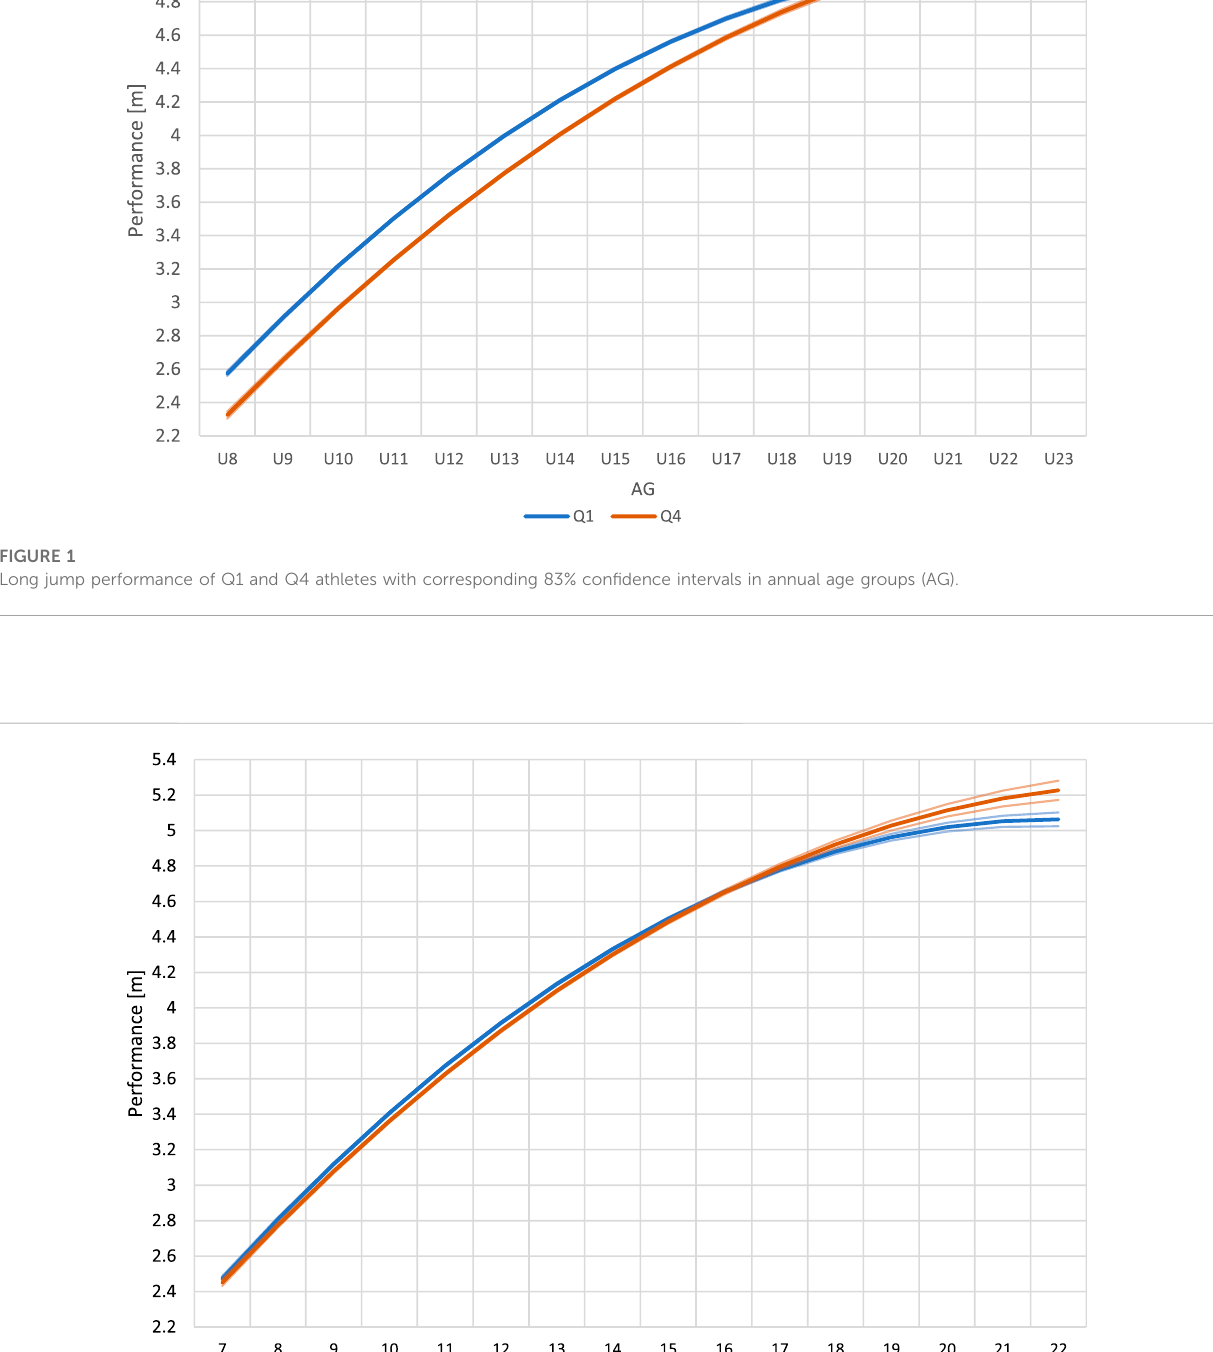
FIGURE 2 Long jump performance of Q1 and Q4 athletes with corresponding 83% con fi dence intervals using exact chronological age at competition (CA).